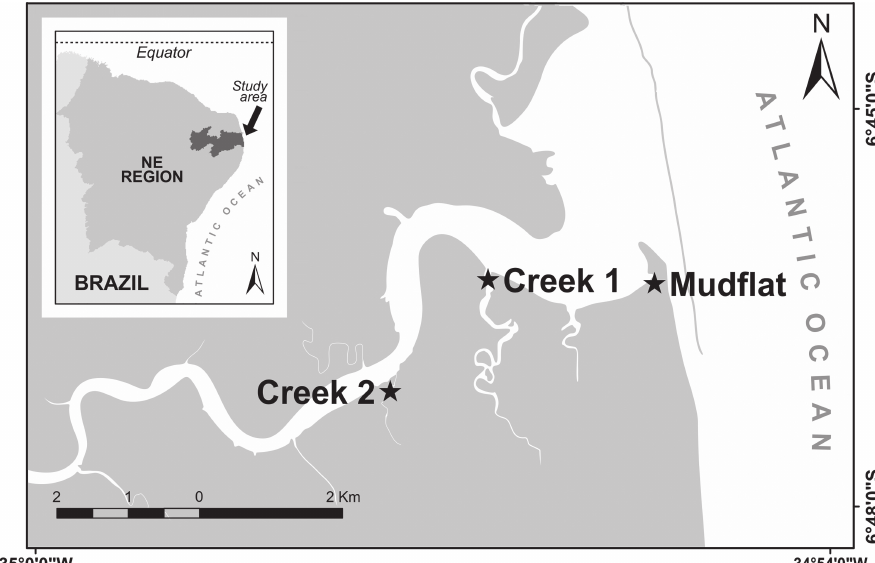
Fig. 1. Study area. Map of the study area with locations of the sampling sites in the Mamanguape River Estuary, Brazil: Mud flat; Tidal Creek 1 and Tidal Creek